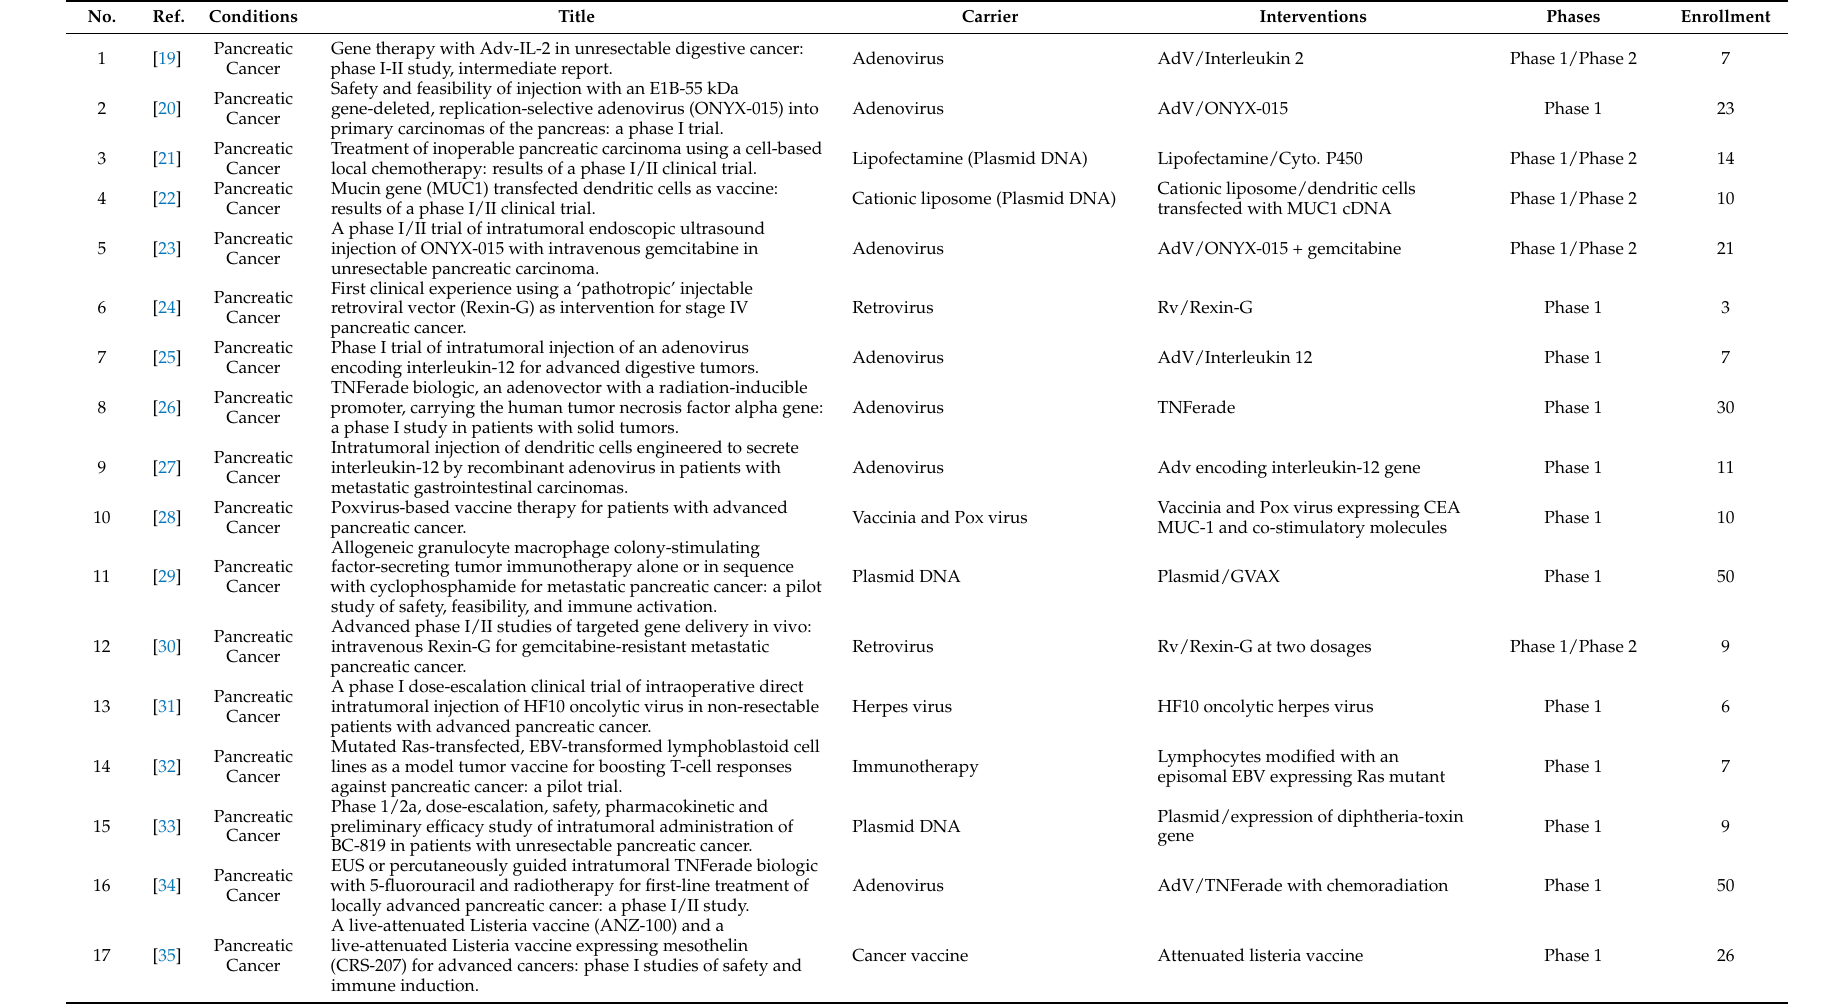
Table 1. Summary of clinical trials